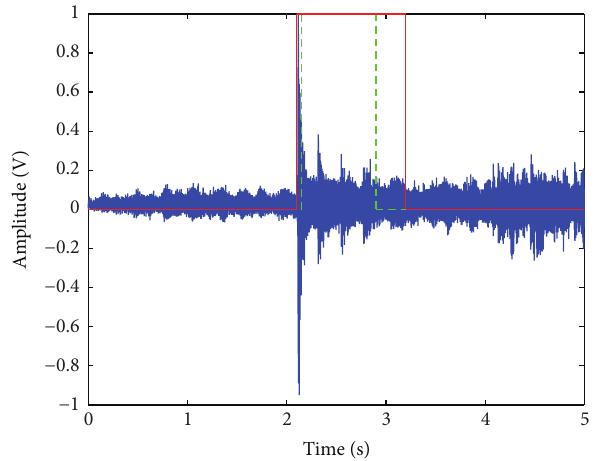
Figure 10: Time-domain waveform comparing an example segmen- tation (red) with the actual endpoints (green).